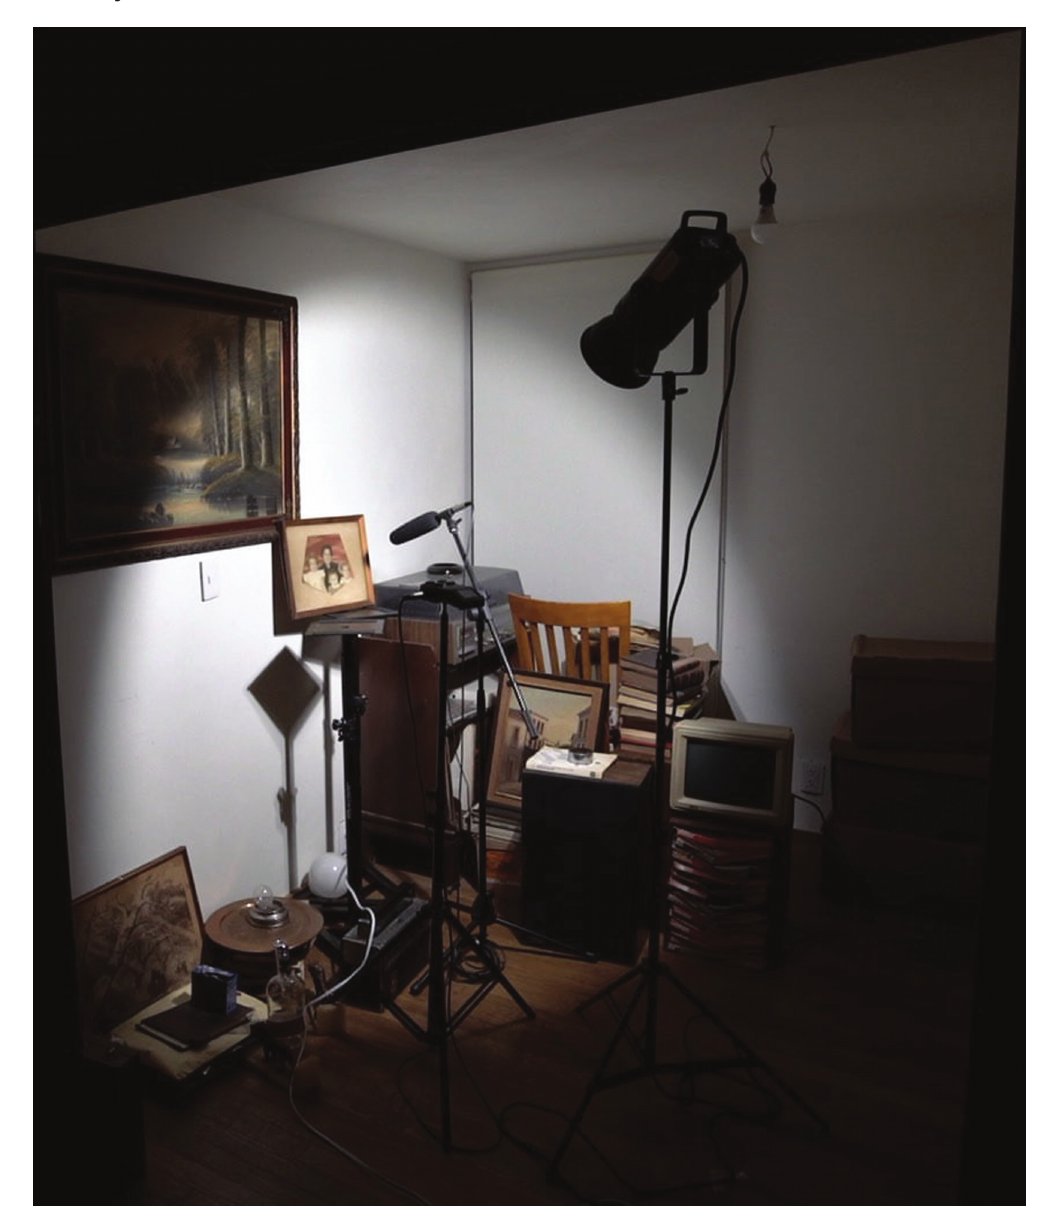
Figure 2. Still from To Remember: An exercise into the decolonisation of the filmmaker’s